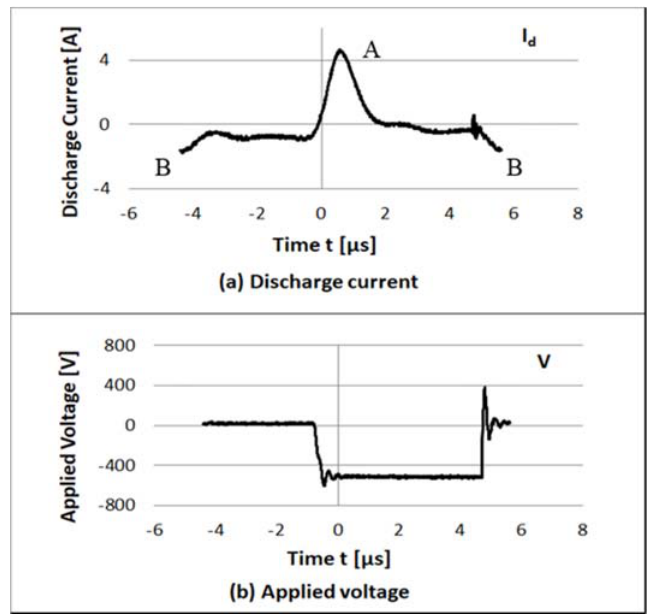
Figure 2. Examples of the voltage and current waveforms at a frequency of 100 kHz in the case without the Al outer anode (the fraction of O 2 is 6.2%). ( a ) Discharge current; and ( b ) applied voltage.